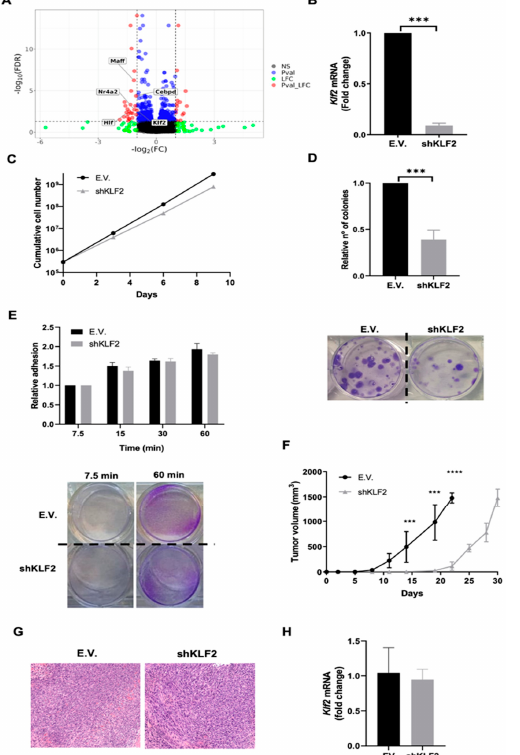
Figure 6. KLF2 is a key effector of the ERK5 biological properties in 3MC-C1 cell line. ( A ) Volcano plot showing transcription factors affected by ERK5 abrogation. Volcano plot showing the effect size of ERK5 attenuation on gene expression (log2 fold change in ERK5-depleted over control cells) versus statistical significance of the difference in expression between conditions ( − log10 of the FDR- adjusted p -values). Each dot represents an independent gene. DEG as determined by statistical significance (FDR < 0.05), effect size (|Log2FC| > 0.99) or both are shown in blue, green, and red colors respectively. Text labels show the identity and location of the transcription factors significantly affected (FDR < 0.05 and |Log2FC| > 0.99) by ERK5. ( B ) RT-qPCR showing effective knock-down of Klf2 expression in 3MC-C1 cells infected with lentiviral vectors coding for empty vector (E.V.) or an shRNA specific for Klf2 (shKLF2), using β -2-microglobulin ( B2m ) as an endogenous control. E.V. cells were refereed as 1. Histogram shows the average of 3 independent pools of infection. ( C ) For growth curves, 3 × 10 5 E.V. or shKLF2 3MC-C1 cells were seeded in 100 mm plates. Every 3 days, cells were counted and replated in the same manner up to day 9. Graphic shows the cumulative cell number from a representative experiment out of 3 with nearly identical results in different pools of infections. ( D ) Upper panel: Relative number of colonies obtained in clonogenic assays of E.V. or shKLF2 3MC-C1 cells. Colonies formed by E.V. cells were considered as 1. Lower panel: Representative image of a colony formation assay at 7.5 and 60 min. ( E ) Upper panel: Relative adhesion of E.V. or shKLF2 3MC-C1 cells was assessed by crystal violet staining at different time points. Graphic shows mean of 3 independent experiments performed in triplicated cultures with 3 different pools of infection. Lower panel: Representative image of adhesion assays at 7.5 and 60 min. ( F ) Nude mice (n = 4) were inoculated with 5 × 10 5 E.V. and shKLF2 3MC-C1 cells, and tumor growth was analyzed at the indicated times. Final tumor weight for E.V.-derived tumors was 0.30 g ± 0.05 and for shLKF2-derived tumors was 0.29 ± 0.09. The experiment was performed by using another pool of infections with nearly identical results. ( G ) Representative images of the histological study of tumors obtained from E.V. and shKLF2 3MC-C1 cells. Pictures are depicted at a 20 × magnification. ( H ) RNA from tumors induced by E.V. and shKLF2 3MC-C1 cells was extracted, and Klf2 expression levels were measured by RT-qPCR in triplicate using Mapk1 as an endogenous control. The graphs/histograms represent the mean ± SD of 3 independent experiments performed in triplicate cultures from different pools of infections, if not otherwise indicated. *** p < 0.001, **** p <